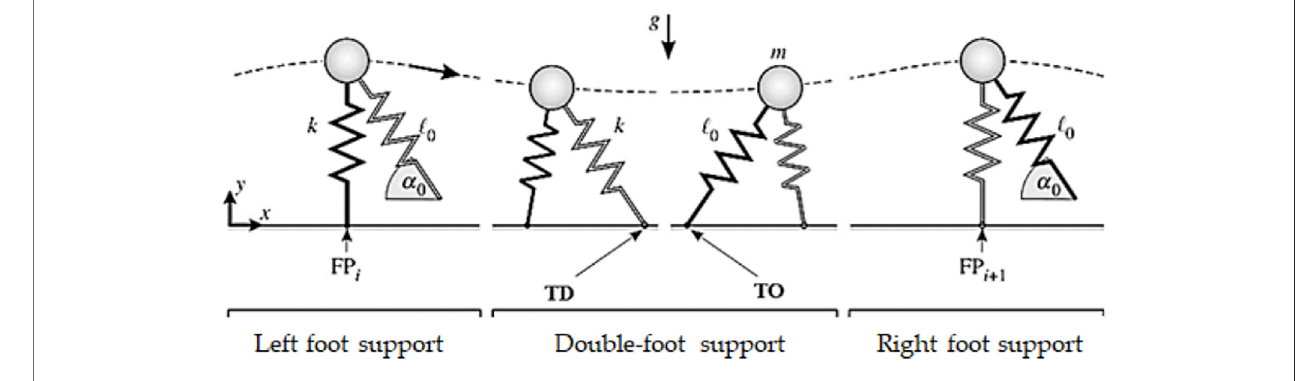
FIGURE 1 | Biped walking force model (Gurney et al.).